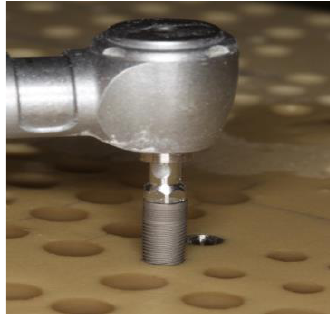
Figure 1. Implant placement in dense bone simulant.